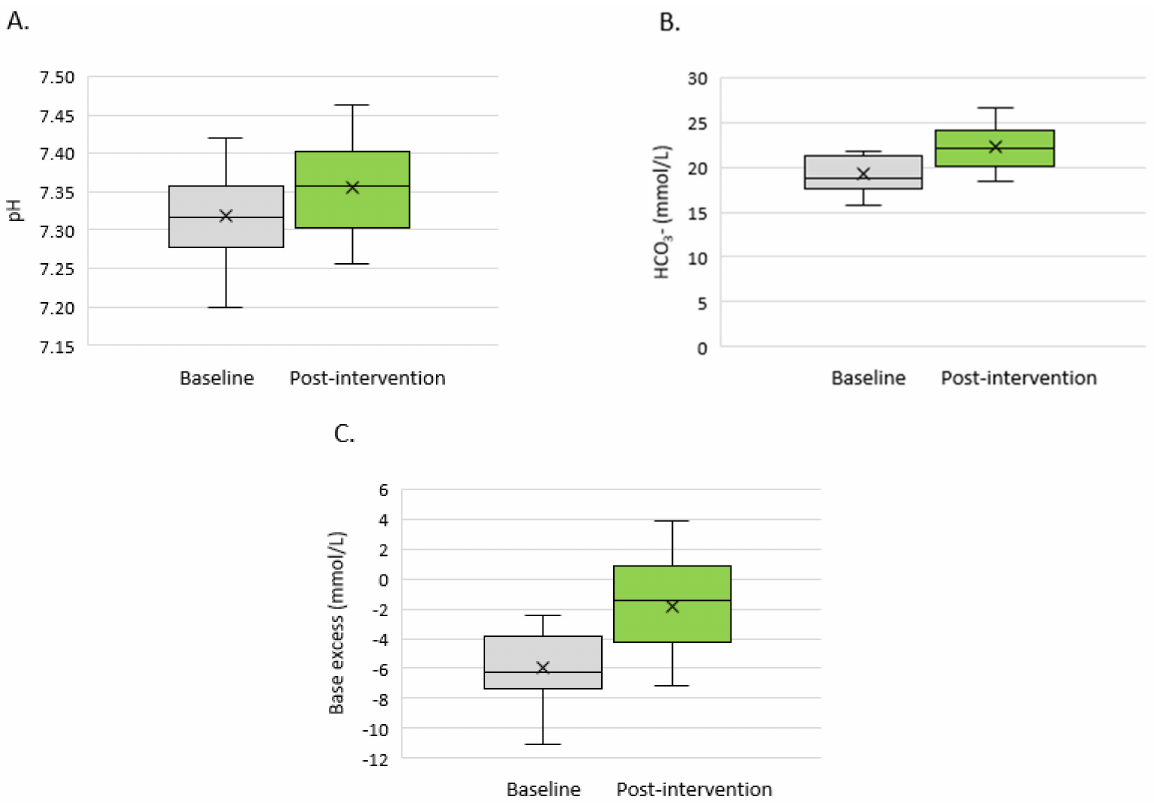
Figure 1. Acid–base balance parameters at the baseline visit and after a 3-month sodium bicarbonate administration in non-dialysed CKD 3–5 stages patients ( n = 18): ( A ) pH, ( B ) HCO 3- (mmol/L) and ( C ) base excess (mmol/L).